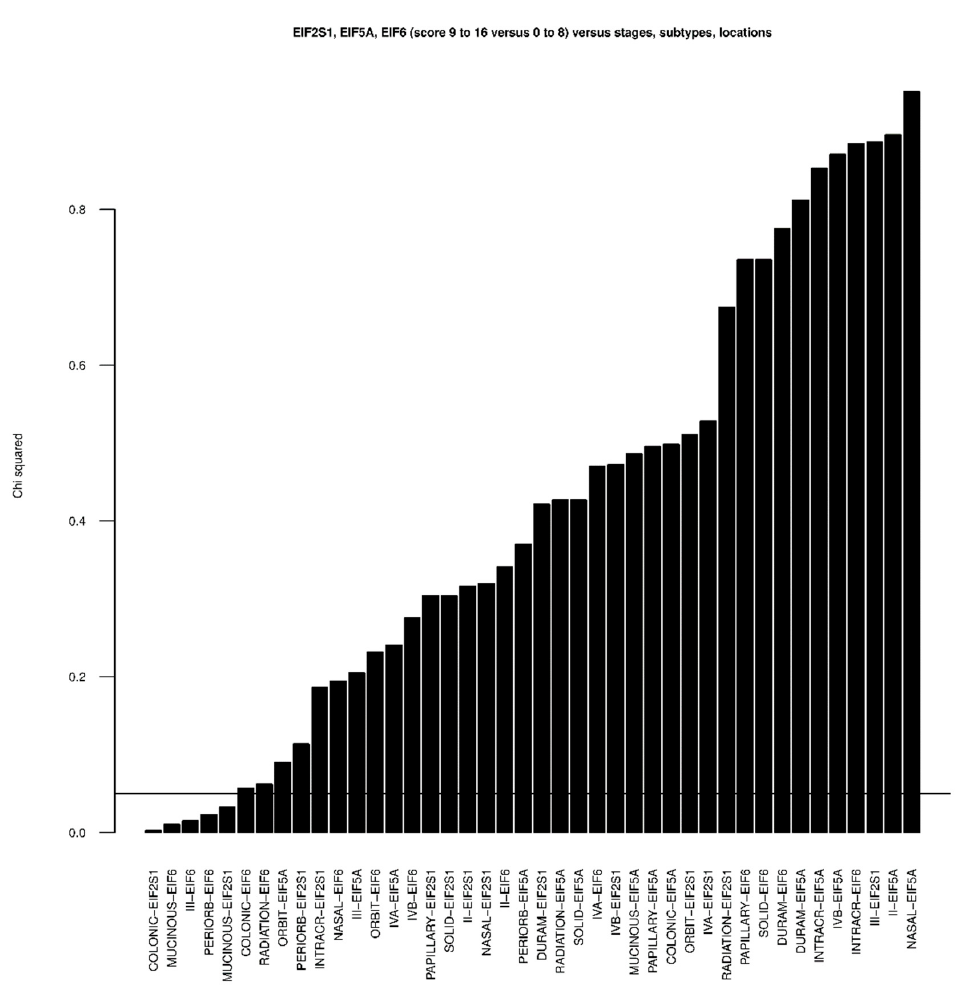
Figure 4. Chi 2 p -values based on the scores for the proteins EIF2S1, EIF5A and EIF6 in combination with each subtype, location, stage and radiotherapy. Scores of 9 to 16 were considered as ‘yes’, scores of 0 and 8 as ‘no’. The horizontal line marks the threshold of 0.05.